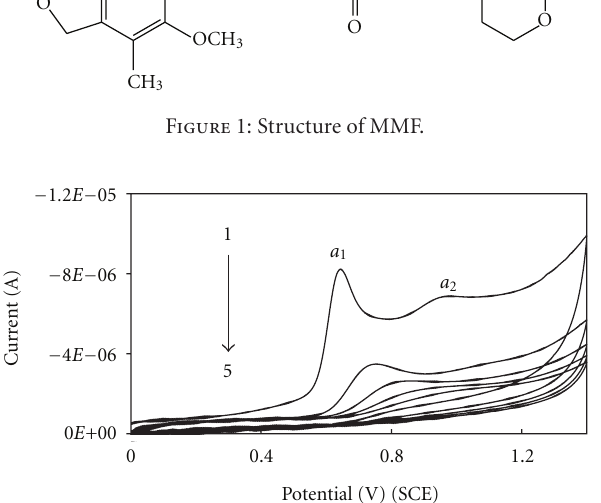
Figure 2: Multisweep cyclic voltammograms of 1.25 × 10 − 4 MMMF in phosphate bu ff er of 6.0 pH at a scan rate 100 mVs − 1